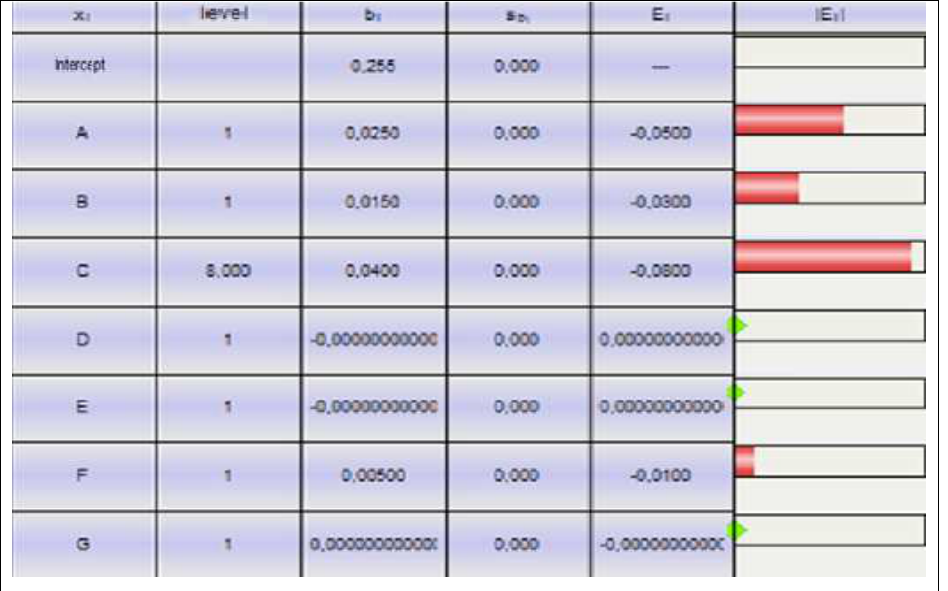
Table 3 – Results of screening